Question: How would you classify this visualization?
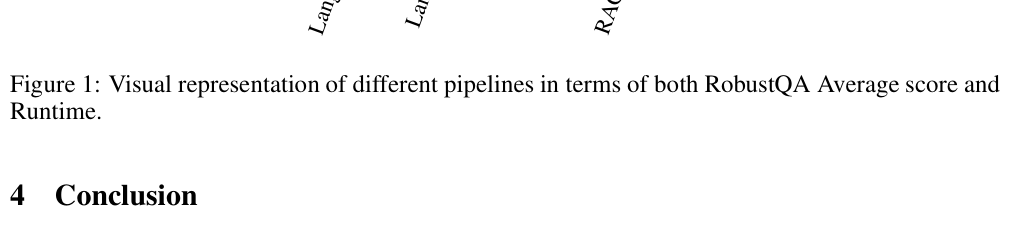
Answer: bar